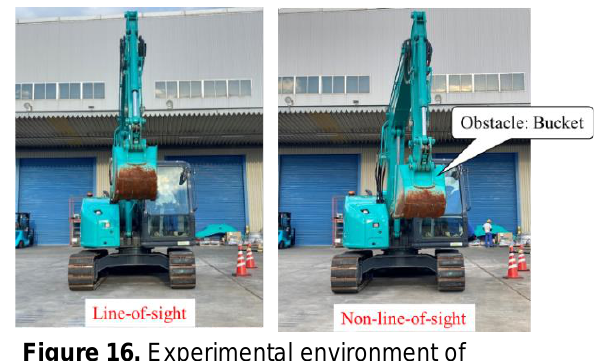
Figure 18. Average UDP throughput results considering position for excavator’s bucket (the distance between the PC and the controller is 10 m). The black bar is the results of line-of- sight communication, and the white bar is results of non-line-of-sight